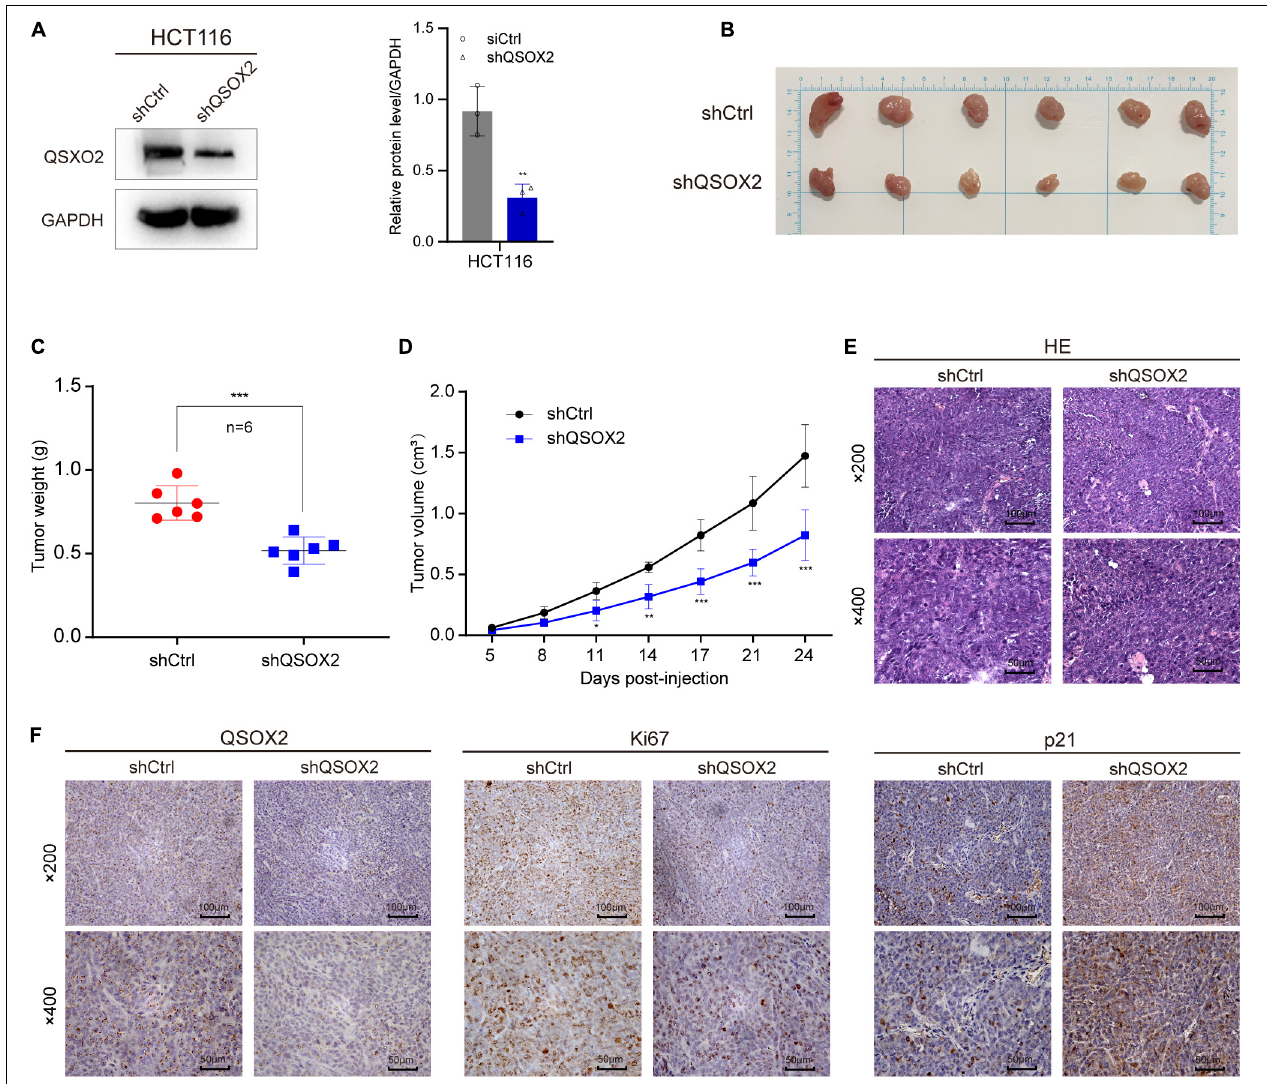
FIGURE 6 | QSOX2 promotes CRC cell proliferation in vivo . (A) The protein expression of QSOX2 in HCT116 stable transfected cell line was confirmed by Western blot assay (Left) . Densitometry values of QSOX2 normalized to GAPDH (Right) . (B) The dissected subcutaneous tumor in mice formed by the shCtrl and shQSOX2 groups ( n = 6 in each group). (C) Analysis of the weight of dissected xenograft tumors. (D) The growth curve of xenograft tumors in mice. (E) The sections of xenograft tumors were stained by H&E and IHC using QSOX2, Ki67, and p21